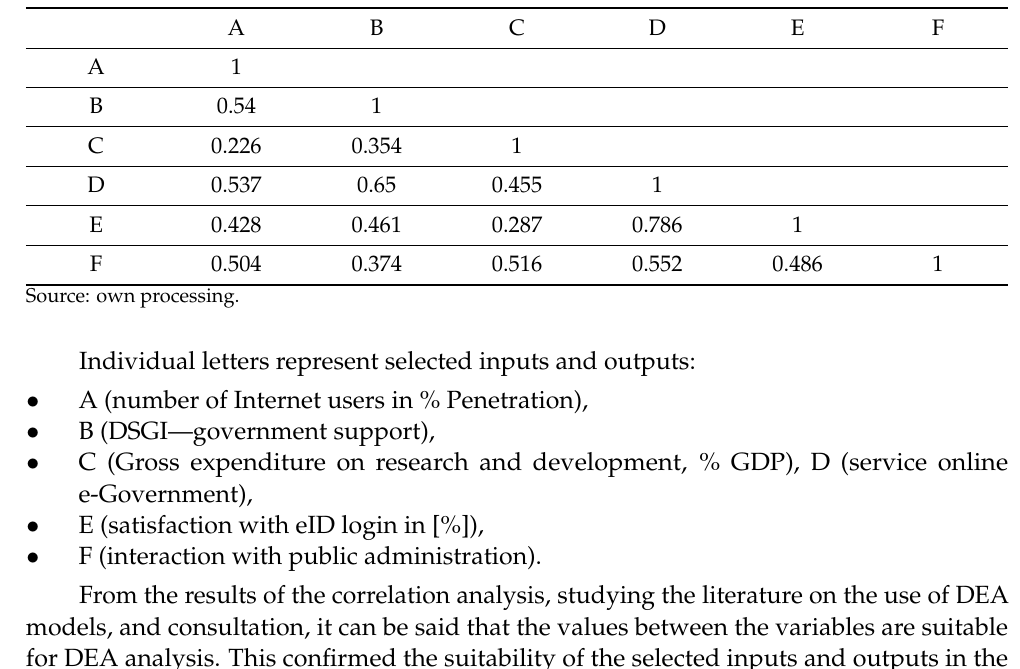
Table 10. Values of correlation coefficients between inputs and